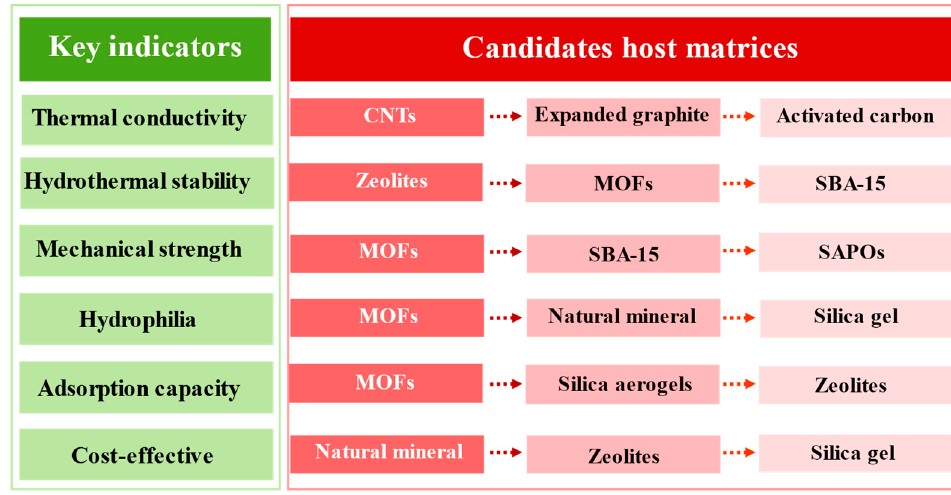
Figure 13. Key indicators for candidate host matrices used in the composites.